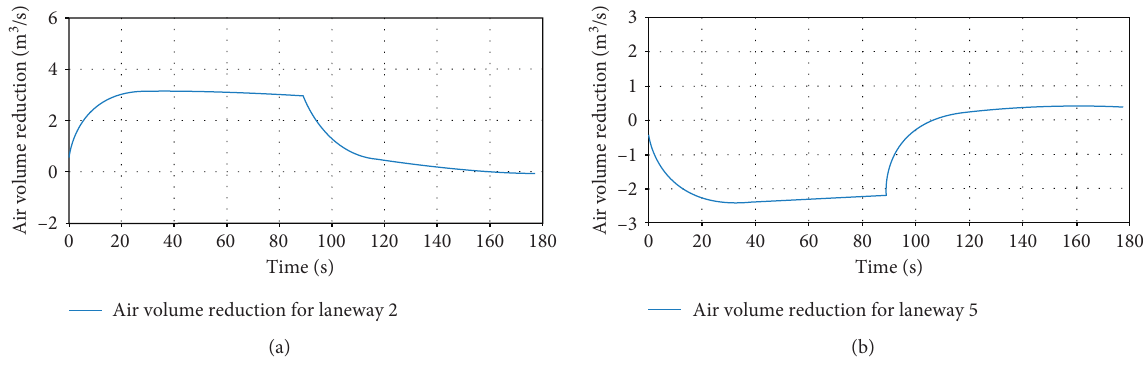
Figure 6: Air volume reduction for laneways 2 (a) and 5 (b) with mine car stops moving to windward.